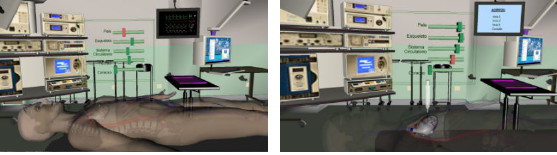
Figure 13. Setting transparency in the model. Internal structures in